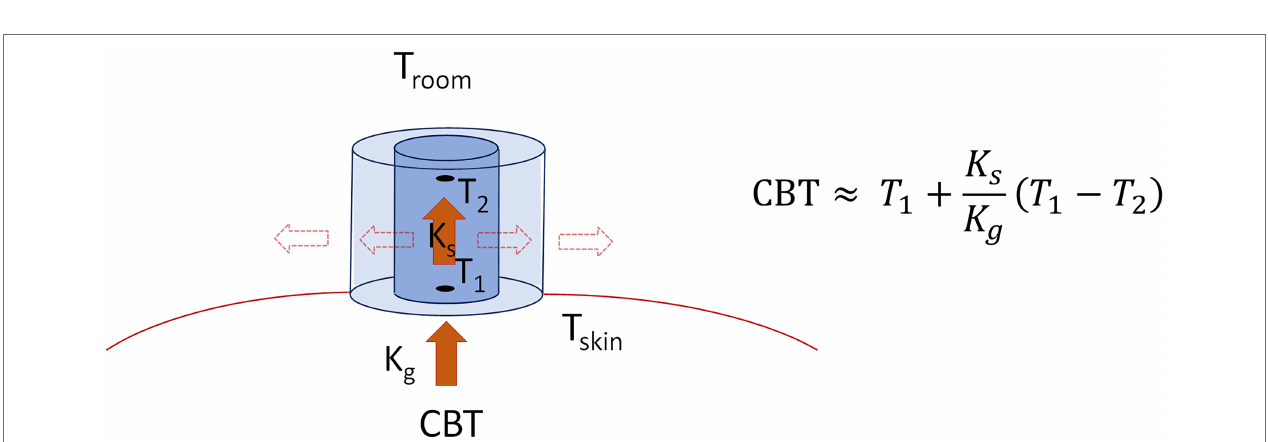
FIGURE 2 | Schematic representation of the Double Sensor building blocks and core body temperature (CBT) estimation principles. The Double Sensor is composed by two temperature sensors (black dots), measuring temperatures T 1 (approximating skin temperature T skin ) and T 2 (approximating ambient temperature T amb ), respectively, which are separated by a disk of insulating material (in blue) of known heat transfer coefficient K s . Neglecting heat flux through lateral walls (dashed arrows), CBT can be estimated simply equating the heat flux from the body to the skin (with body heat transfer coefficient K g ) to the heat flux from the skin through the sensor (red arrows), leading to the equation on the